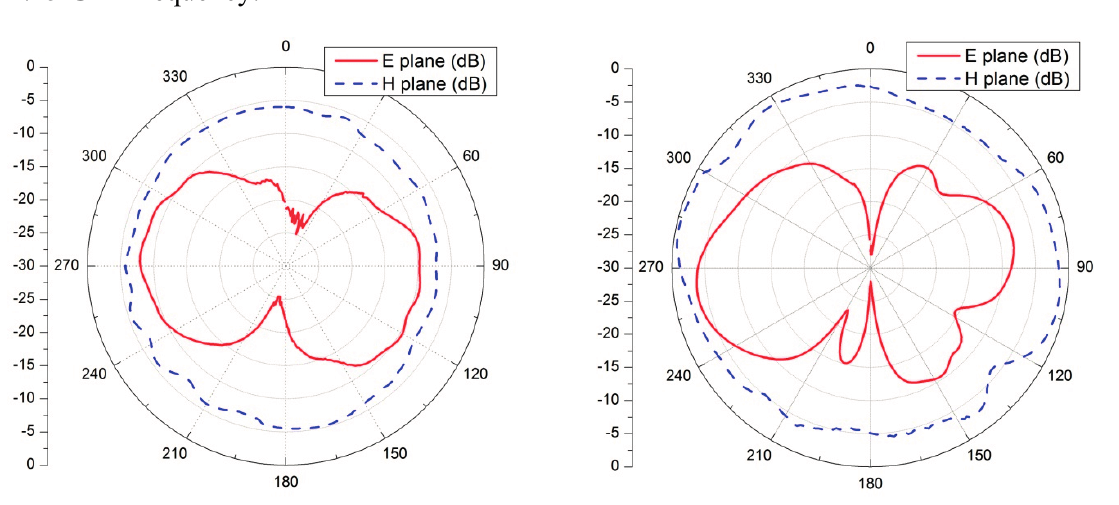
2 Figure 8. ( Left ) Radiation pattern of the commercial dipole WiFi antenna and ( Right ) radiation pattern of the textile integrated fiber dipole antenna, both operating at 2.45 GHz frequency.